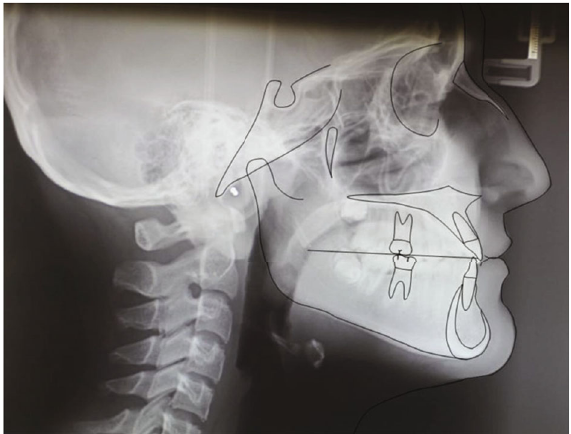
Figure 1: Initial lateral cephalogram. Table 1: Initial cephalometric